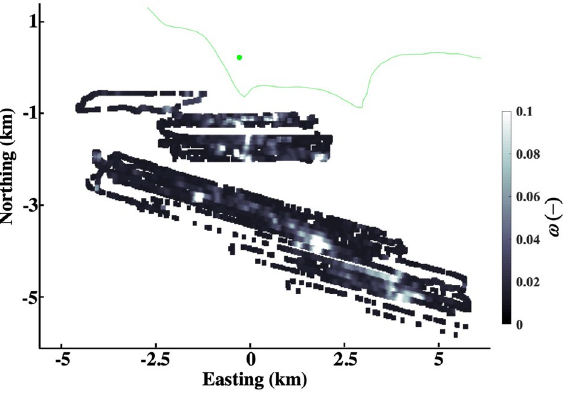
Figure 7. Sonar return, ω, map for 22-m grid, gap filled from 56-m gridded data. Data key on figure. Origin is at 34.414949° N, 119.879690°